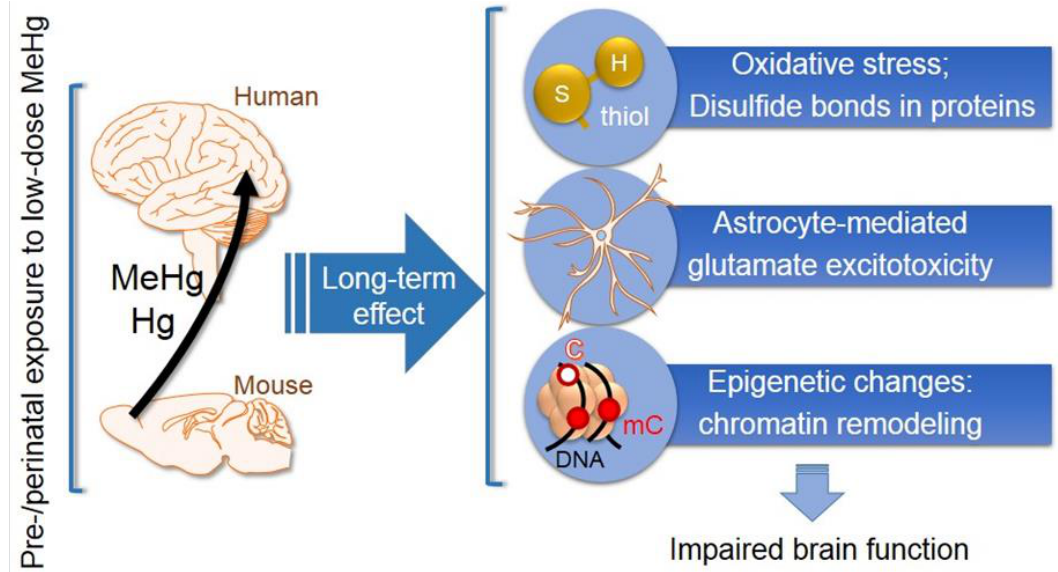
Figure 3. The main mechanisms for the long-term effect of pre/perinatal exposure to methyl mercury (MeHg) on impaired brain function. Chronic exposure to MeHg leads to brain-specific accumulation of MeHg and inoHg in the developing fetus. MeHg may exert its effects on cell function and gene expression by: (1) binding to the thiol groups in glutathione, seleno-dependent enzymes and other proteins pertaining to the antioxidant system; (2) inducing astrocyte-dependent glutamate excitotoxicity and (3) by epigenetic reprogramming of gene expression through chromatin remodeling. A nucleosome composed of DNA and histone octamer is shown; epigenetic changes in DNA methylation are schematically represented by C (unmethylated cytosine) and mC (methylated cytosine).